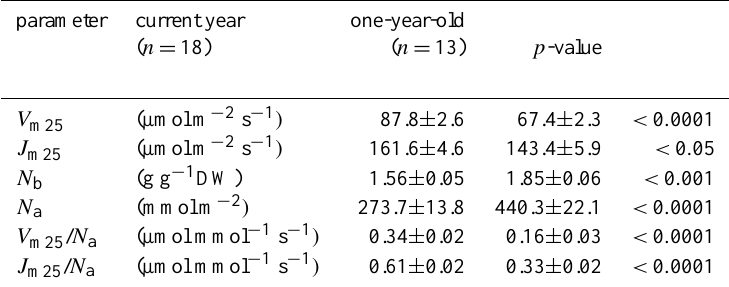
Fig. 4. Validation of the leaf physiological submodel. Scatter plot of (a) simulated versus measured half-hourly averaged net leaf photosyn- thesis ( A n ) , and (b) simulated versus measured half-hourly averaged transpiration ( E) . The submodel was validated against the data of the second day of two day-night-day periods (36h) of continuous gas exchange measurements. Grey lines are the 1:1 lines. Black lines are the linear regression curves. R 2 =coefficient of determination; RMSE=root-mean-square-error; d =Willmott’s index of agreement. Table 3. Photosynthetic parameters versus needle nitrogen (N) content. Results (mean ± SE) for current-year needles and one-year-old needles, from summer measurements (July and August 2007), with p -values of t -test comparison. For an explanation of the symbols and parameters, see Table 1. parameter current year